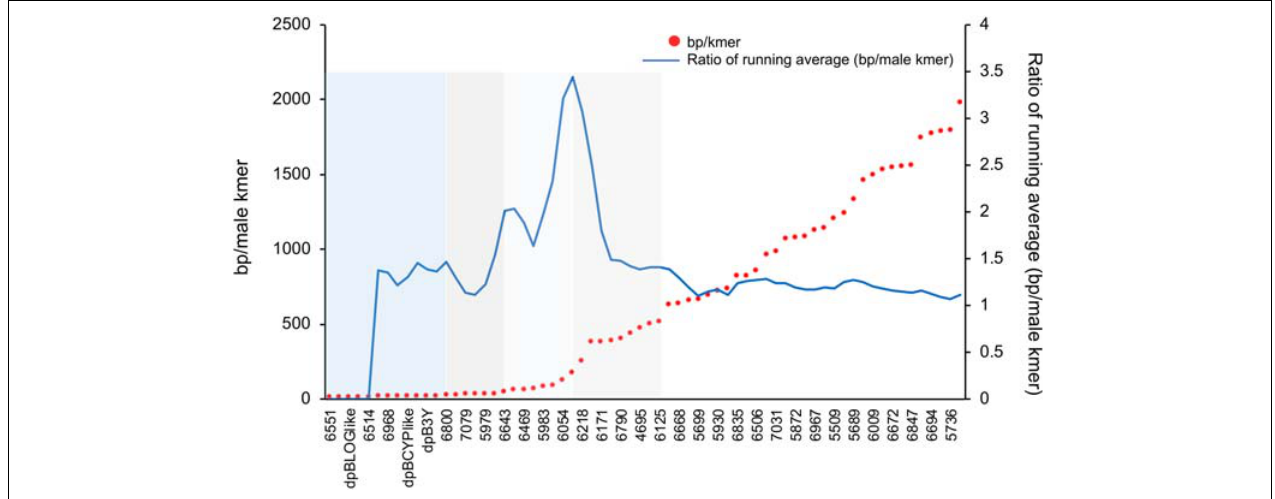
FIGURE 4 | A plot of male-specific kmer density in contigs with significant differences between each assembled haplotype for three date palm male/female combinations. The density on the haplotype with the most kmers is plotted as base pairs of sequence per male-specific kmer. To identify regions of significant changes in the density, the running average of the leading five to trailing five contigs male-specific kmer density is plotted.